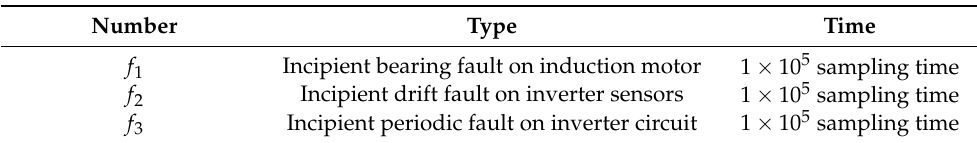
Figure 7. The electric traction system of a high-speed train. Table 1. Fault